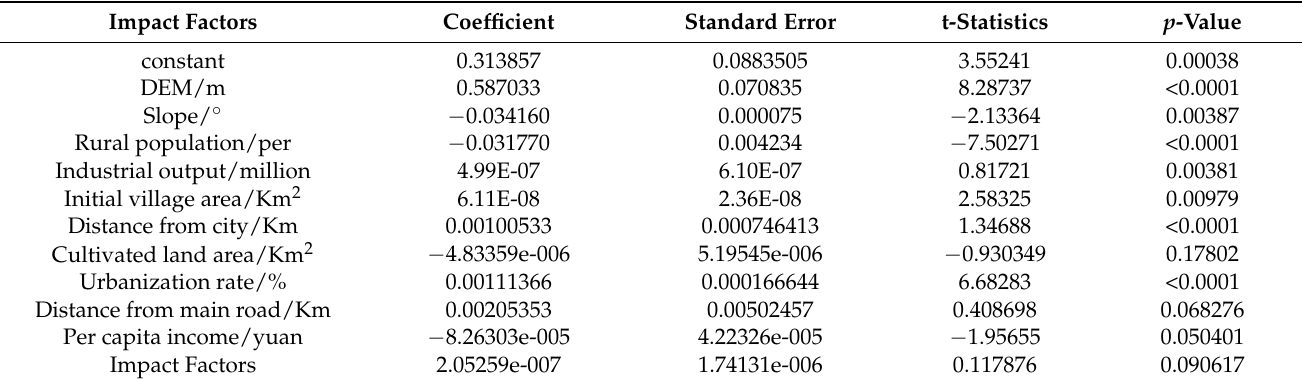
Table 5. Spatial lag model